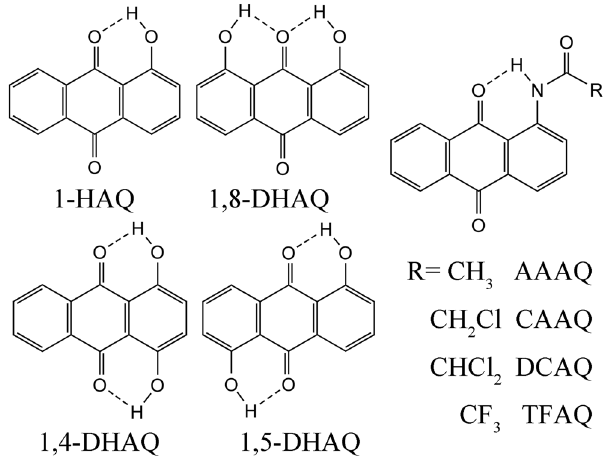
Figure 1. Molecular structures of HAQ, DHAQs and AYAAQs related in this